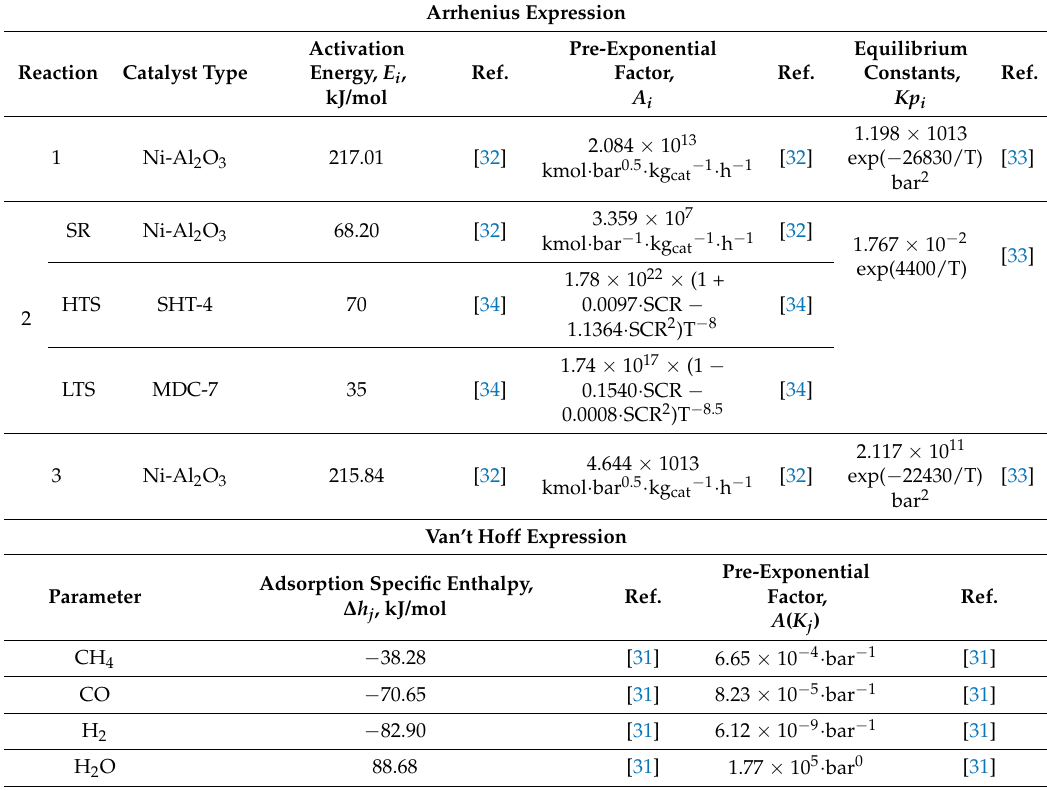
Table 1. Adsorption and equilibrium constants and kinetic parameters for Equations